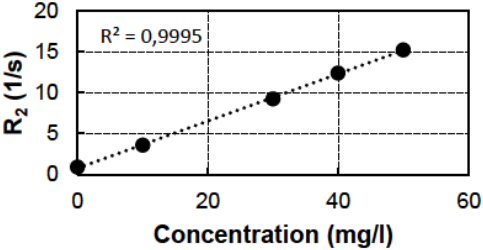
Figure 4: Relaxation rate R 2 as a function of Fe 3+ concentration.